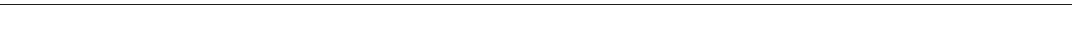
Fig. 1 CMT rat Schwann cells display impaired endogenous ability to synthesize lipids. a Heatmap (left) shows scaled TPM values (transcripts per million) for differentially expressed genes (adjusted p value <0.05 and log 2 fold change >|0.5|) at P18. Genes downregulated in Tg ( Pmp22 transgenic) versus Wt (wild type) at P18 were further divided into two patterns — genes with increasing TPM in Wt from E21 to P18 (pattern 1) and remaining (pattern 3). Genes upregulated in Tg versus Wt at P18 were further divided into two patterns — genes with increasing TPM in Tg from E21 to P18 (pattern 2) and remaining (pattern 4). Heatmap (right) shows top ten biological process terms (from WebGestalt) for each pattern. b Dorsal root ganglia neuron and Schwann cell co-cultures from wild-type (Wt) and Pmp22 transgenic (Tg) mice revealed impaired myelination in Tg co-cultures. Shown are representative pictures of Wt and Tg cultures 14 days after myelination induction. Myelin is immunostained for MBP (green) and axons for TUJ1 (magenta). Scale = 100 µ m. c Quanti fi cation of ( b ) in a timeline from 8 to 14 days after myelination induction. ( n = 3 – 8 per group and time point, mean ± standard error of mean (SEM), two-way ANOVA, *** p value <0.001). d Differentially expressed genes involved in choline metabolism in Tg versus Wt sciatic nerves at age P18 (KEGG pathway: choline metabolism in cancer). Up- and downregulated genes (adjusted p value <0.05) are shown in red and blue, respectively. Circles represent lipid products. e Wt and Tg co-cultures maintain a reduced myelination competence when grown with delipidated serum (compare to ( c )). Addition of 2 µ g/ml phosphatidylcholine (PC) to the culture medium increases myelination in both groups 10 days after myelination induction ( n = 3 – 6 per group, mean ± standard deviation (SD), one-way ANOVA, and Sidak ’ s multiple comparison post test, * p value <0.05). f When supplied to the myelination medium, Tg co-cultures integrate BODPIPY-labeled phosphatidylcholine (left panels, BODIPY-PC, green, 2 µ g/ml medium) into the myelin sheaths (MBP, magenta), whereas control BODIPY (tagged to pentanoic acid) was not incorporated into the myelin membranes (right panels, 10 days after myelination induction). Cultures were counterstained for nuclei (DAPI, blue). Scale = 100 µ m (blow up 50 µ